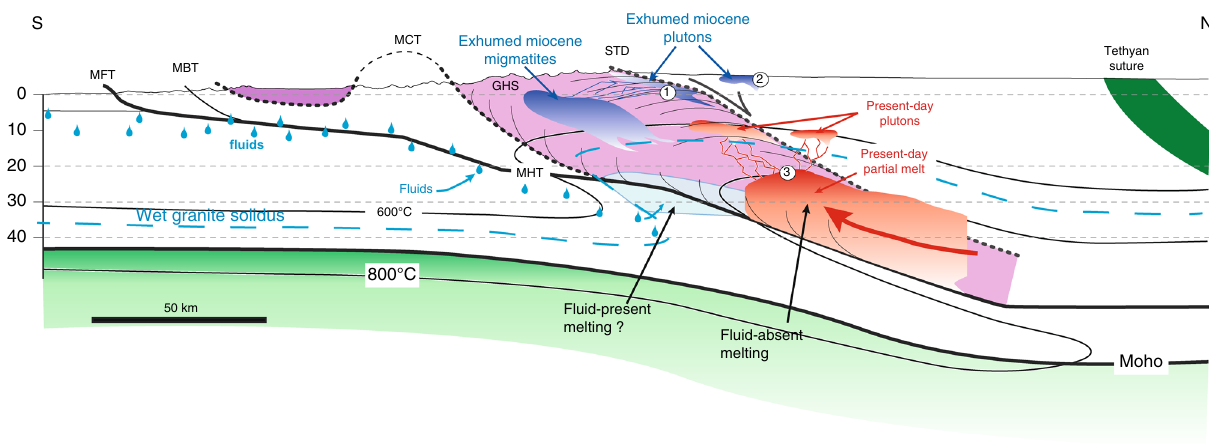
Fig. 7 Schematic diagram of granitic magma production, migration, and emplacement in a schematic cross-section of the Himalaya. The inactive shear zones (i.e., STD and MCT) are shown with bold dotted lines, while the active shear zones (i.e., MBT, MFT, and MHT) are shown as bold straight lines. The red regions identify the present-day location of partial melting plus melt ponding (present-day leucogranite plutons) while the blue areas are exhumed and solidi fi ed granitic rocks (migmatites and plutons). The numbers illustrate the emplacement of granitic plutons (1) below the STD or (2) above the STD while (3) refers to the top of the partial melting region from where the present-day dykes feeding the growing plutons are nucleating. The fl uid identi fi ed by Rawat et al. 40 is delineated by the blue droplets, south of the Main Frontal Thrust, and located within the Indian basement. Melting is obviously not occurring in the cold regions of the Indian basement, but this must represent a fl uid-enriched zone that is buried beneath the chain. What happens to these fl uids is not the kernel of this study but they may well contribute to the process of melting beneath